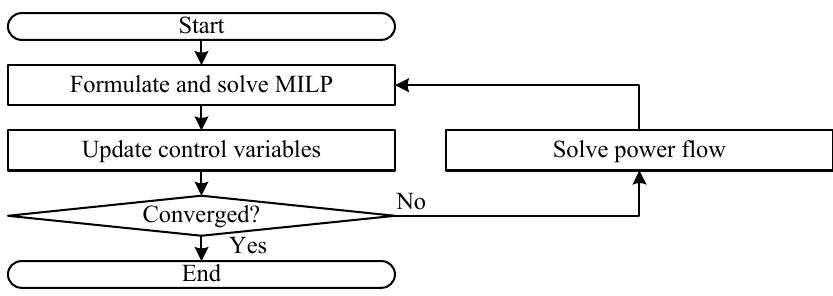
Figure 6. Flow chart of the SMILP. MILP: mixed integer linear